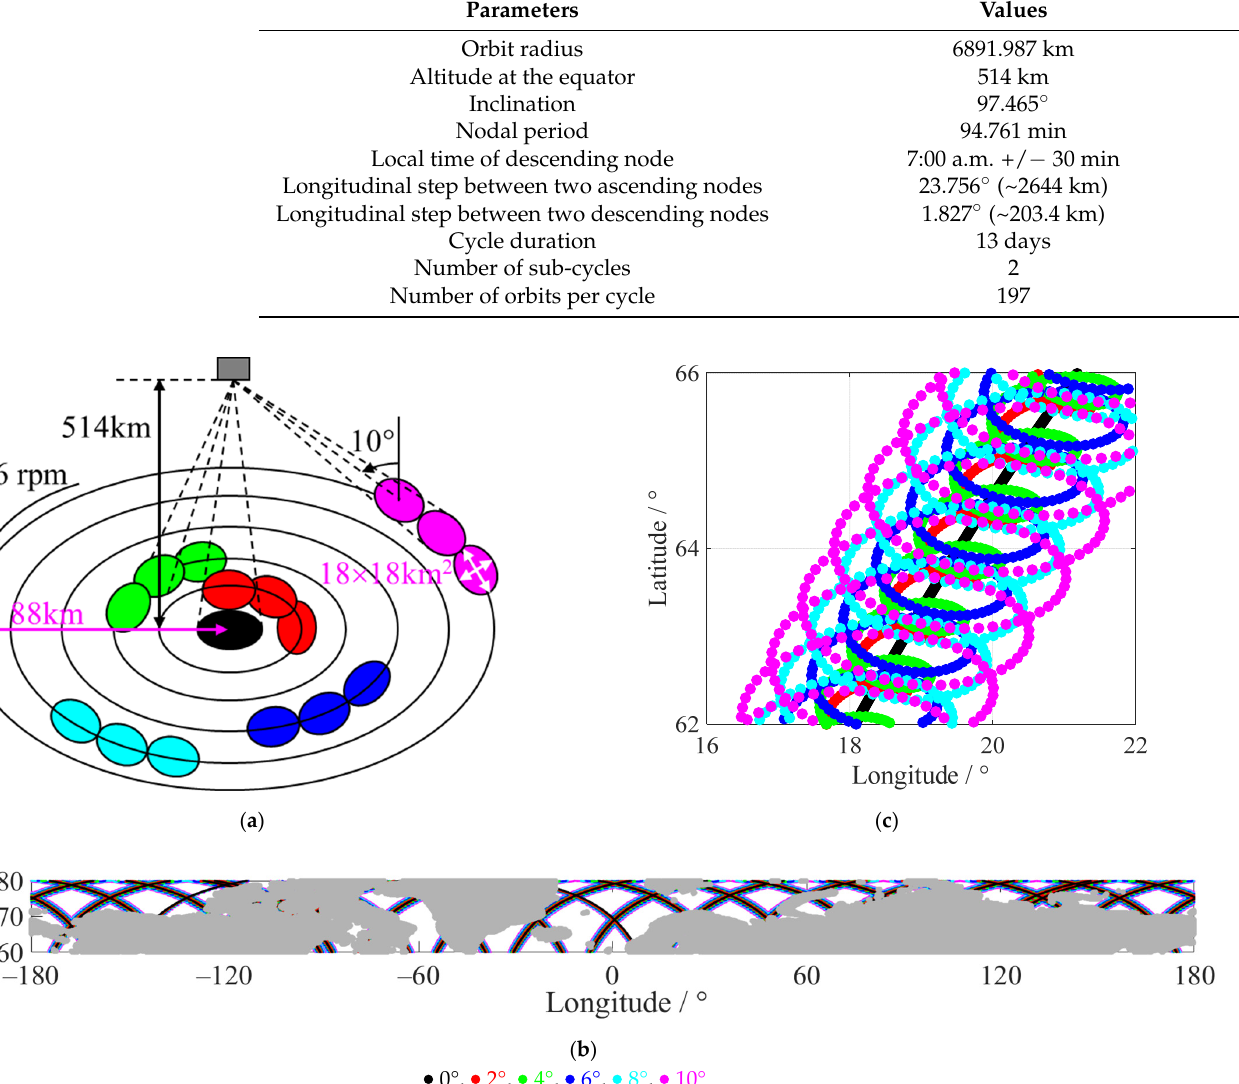
Table 1. CFOSAT orbit characteristics [35].